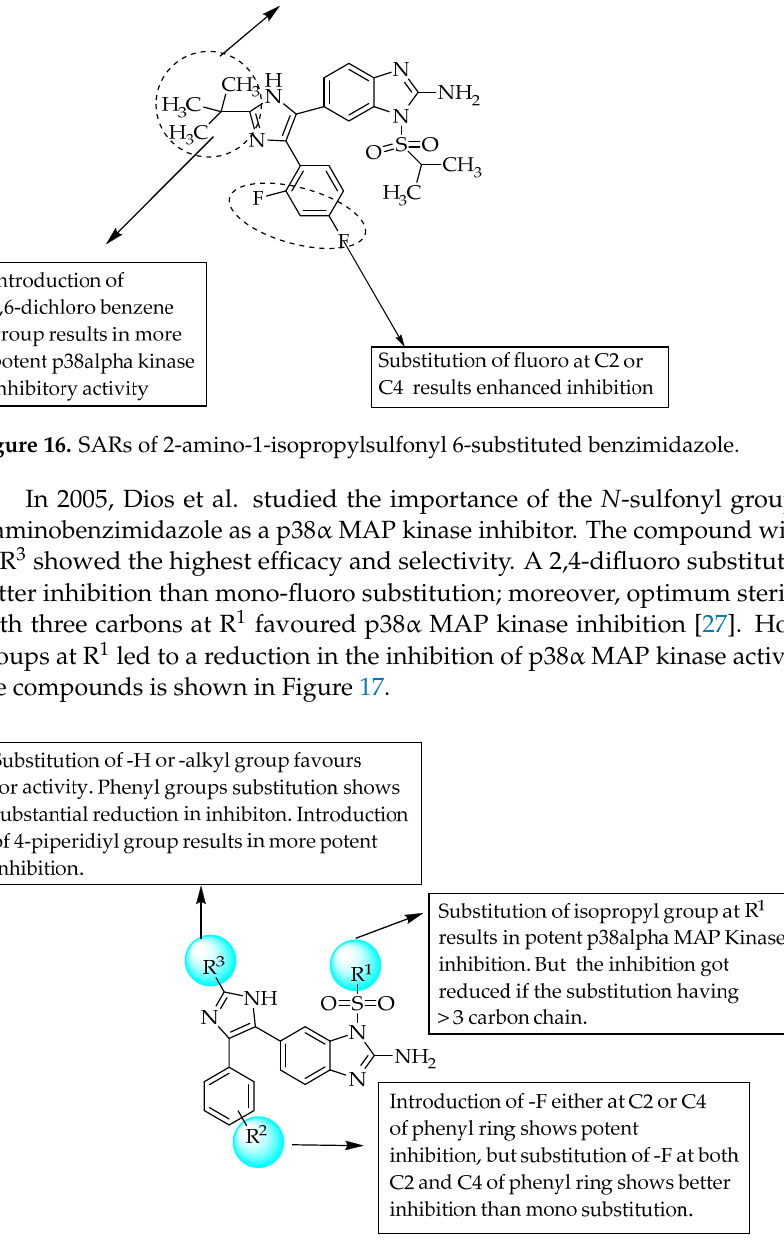
Figure 17. SARs of sulfonyl group incorporated 2-aminobenzimidazoles. Amgen Inc. (South San Francisco, CA, USA) carried out high-throughput